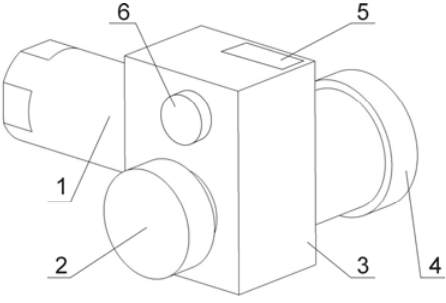
Fig 1 . General view of electro-mechanical